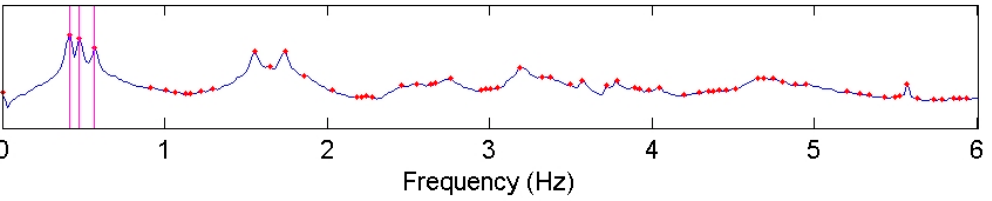
Figure 15. Plot of the first singular values for test building. The first three frequencies are marked by vertical lines.